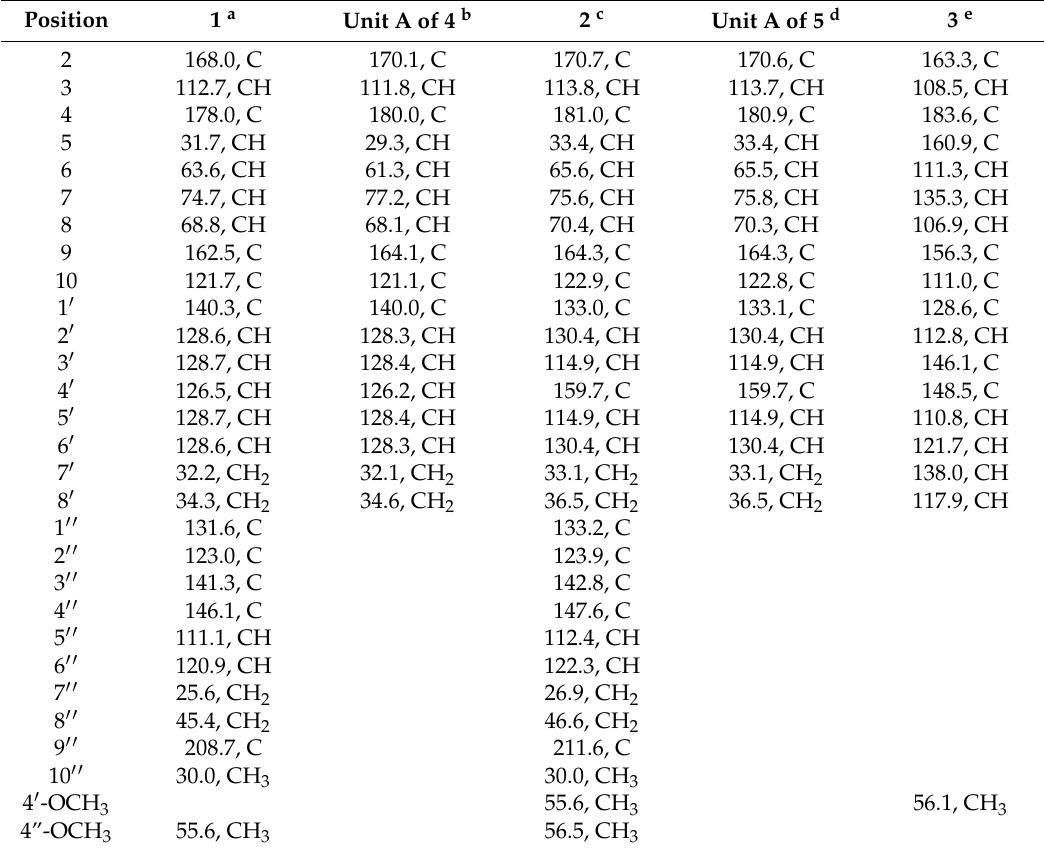
Table 2. 13 C-NMR data for compounds 1 – 3 and unit as of ( − )-6”-hydroxyaquisinenone B ( 4 )